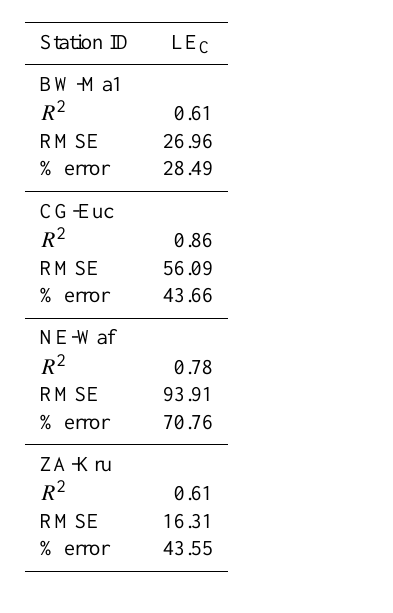
Table 6. Summary results from the comparison of observed monthly LE and PT-JPL LE C .